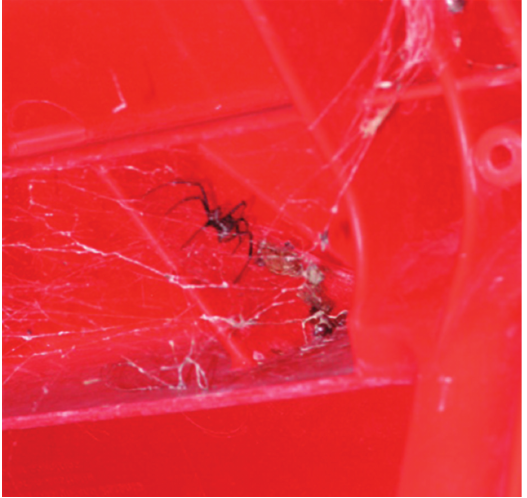
Figure 2: A Redback spider in its native habitat. Photo taken by author (JAC) under a chair in the Alice Springs Hospital cafeteria,